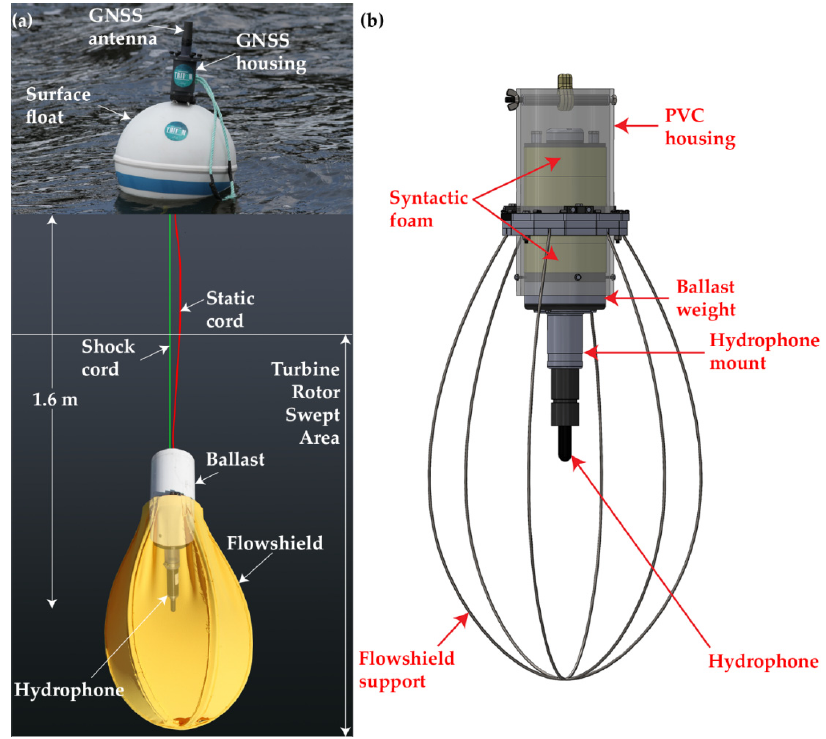
Figure 2. ( a ) The drifting hydrophone system components and configuration including surface buoy, GNSS, shock and static lines connecting the buoy to the lower hydrophone housing and flow shield. ( b ) A drawing of the lower, underwater housing and mounting configuration of the hydrophone sensor and flowshield support structure. Note that both ballast weights and syntactic foam are incorporated in the mounting design to maintain proper sensor orientation and stability at